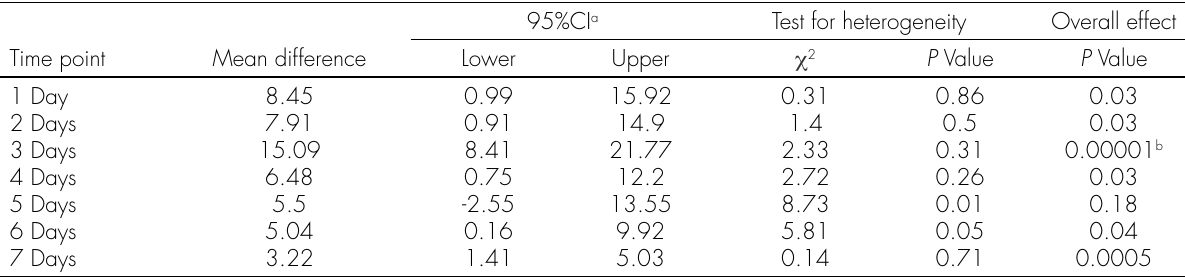
Table VII. Meta-analysis data summary: Structured text follow-up vs control